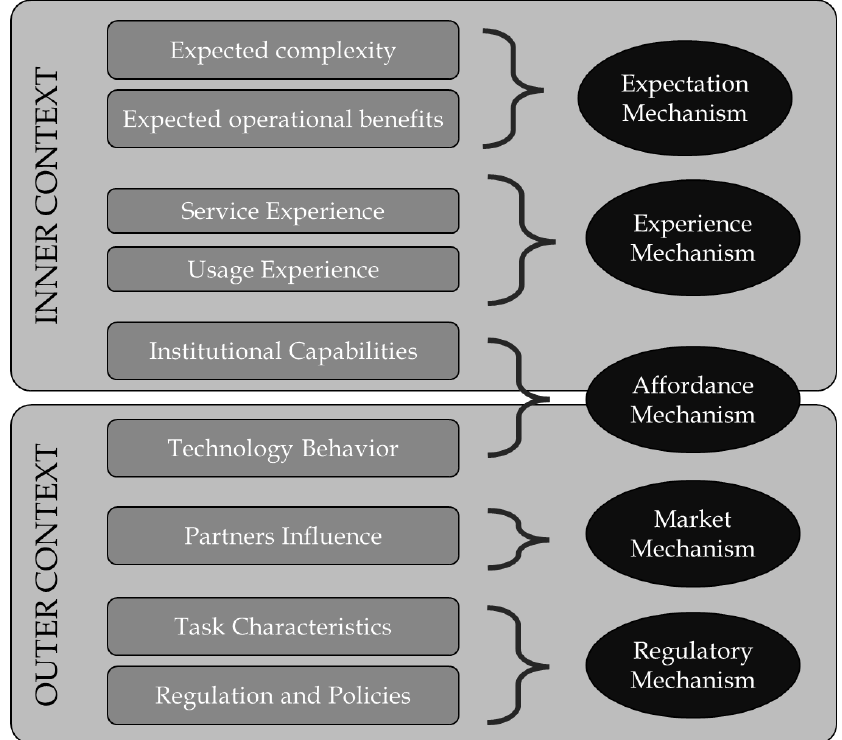
Figure 3: Retroduction process and hypothesized mechanisms